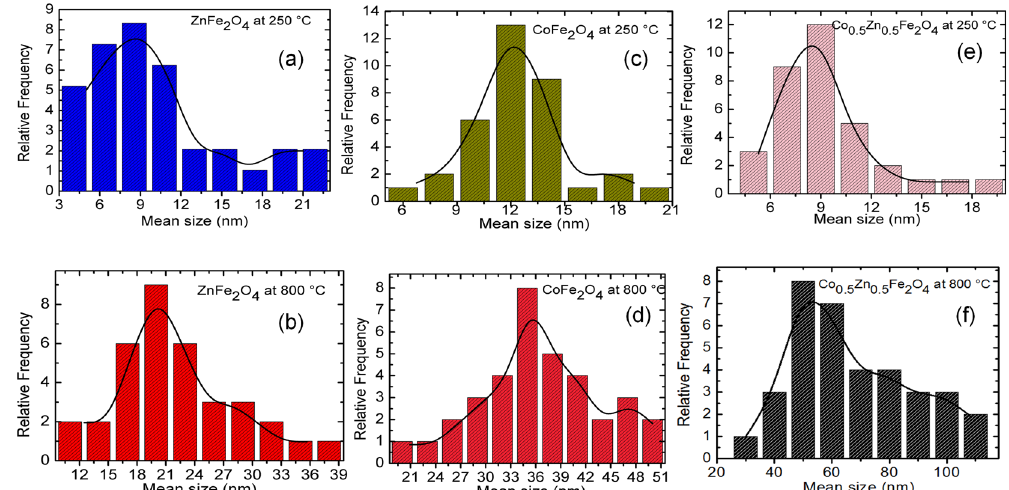
Fig. 6 Histogram for ZnFe 2 O 4 , CoFe 2 O 4 , and Zn 0.5 Co 0.5 Fe 2 O 4 NPs after calcination at 250 and 800 °C. ZnFe 2 O 4 NPs after calcination at a 250 °C and 800 °C ( b ). CoFe